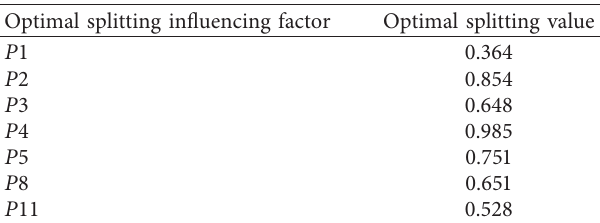
Figure 6: Relationship between N-tree and OOB. Table 2: Optimal splitting influencing factor and the optimal splitting value of